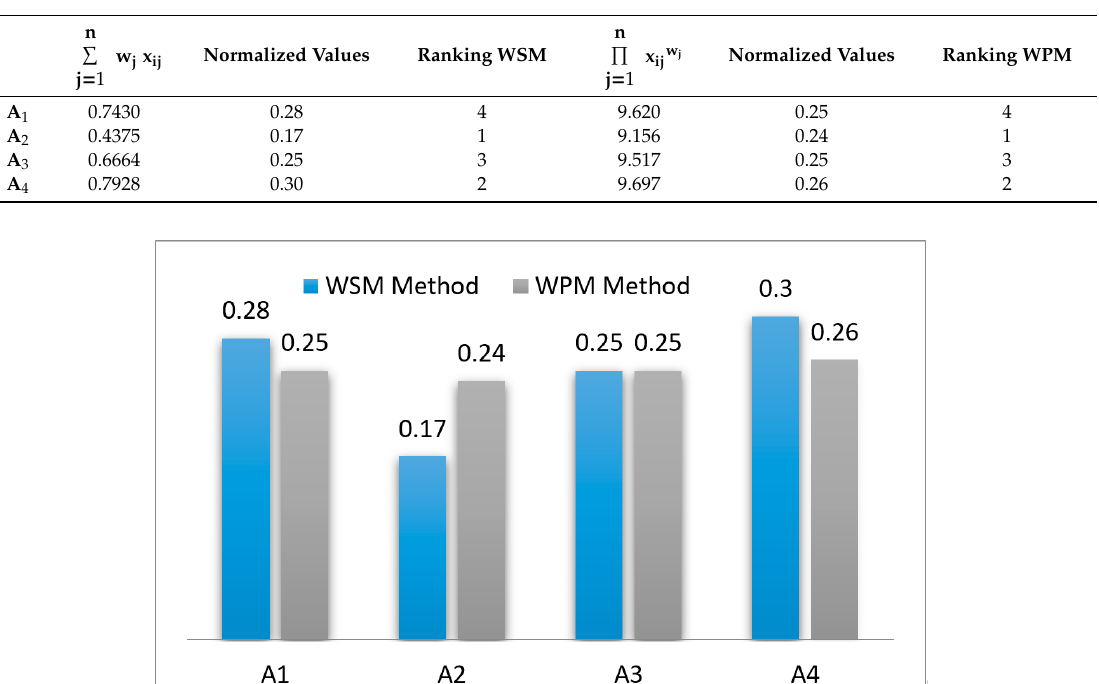
Table 23. The final result of the judgments matrix using the WSM and WPM methods.